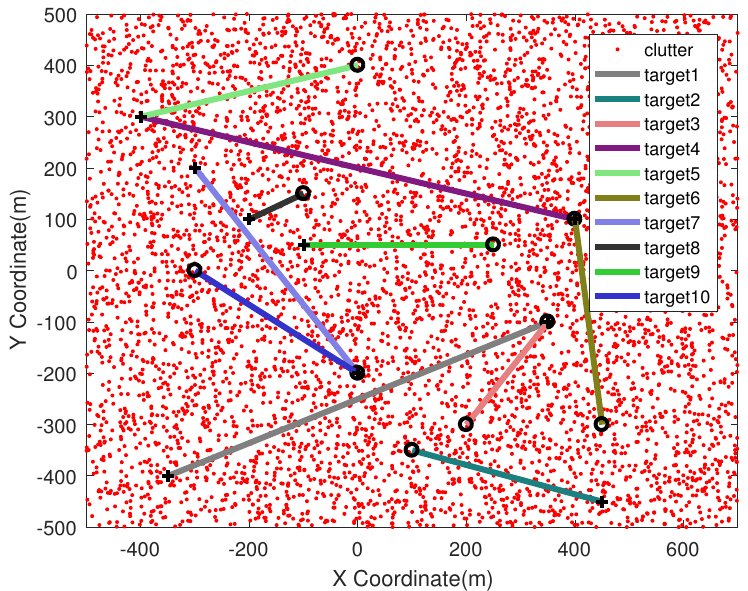
Figure 4. Target trajectories: ‘ + ’ represents locations of target birth; ‘ (cid:13) ’ represents locations of target